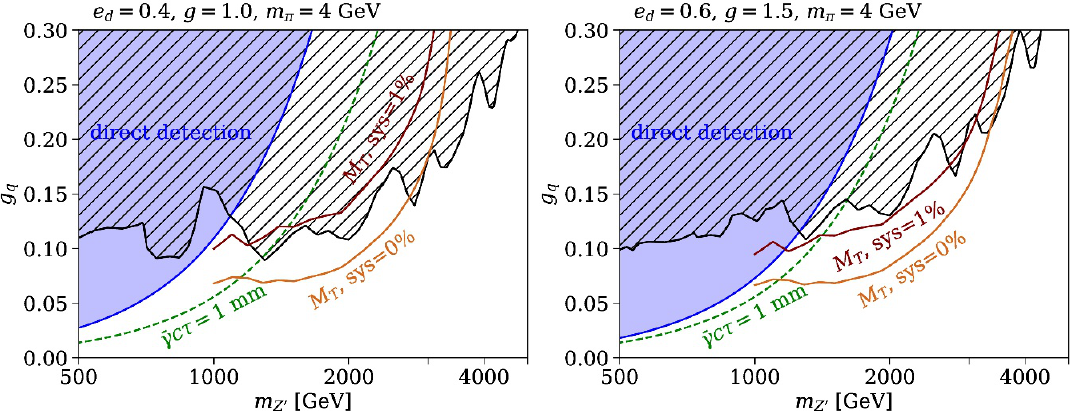
Figure 7 . Expected sensitivity of the M T -based analysis proposed in ref. [23] compared to the direct detection constraints from (cid:12)gure 2 and the LHC exclusion bounds from (cid:12)gure 5 for di(cid:11)erent assumptions on systematic